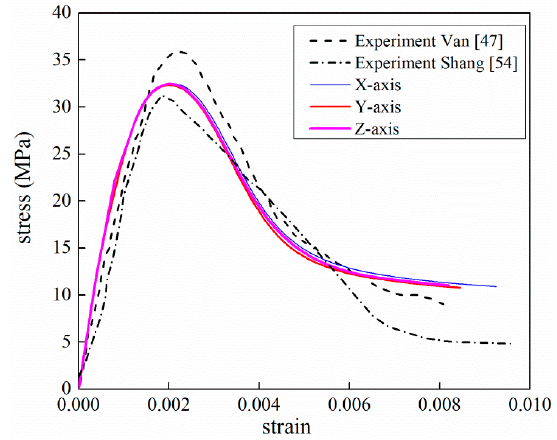
Figure 20. Comparison of stress–strain curves between experiment and simulation under compression (experimental data from [47] and [54]).